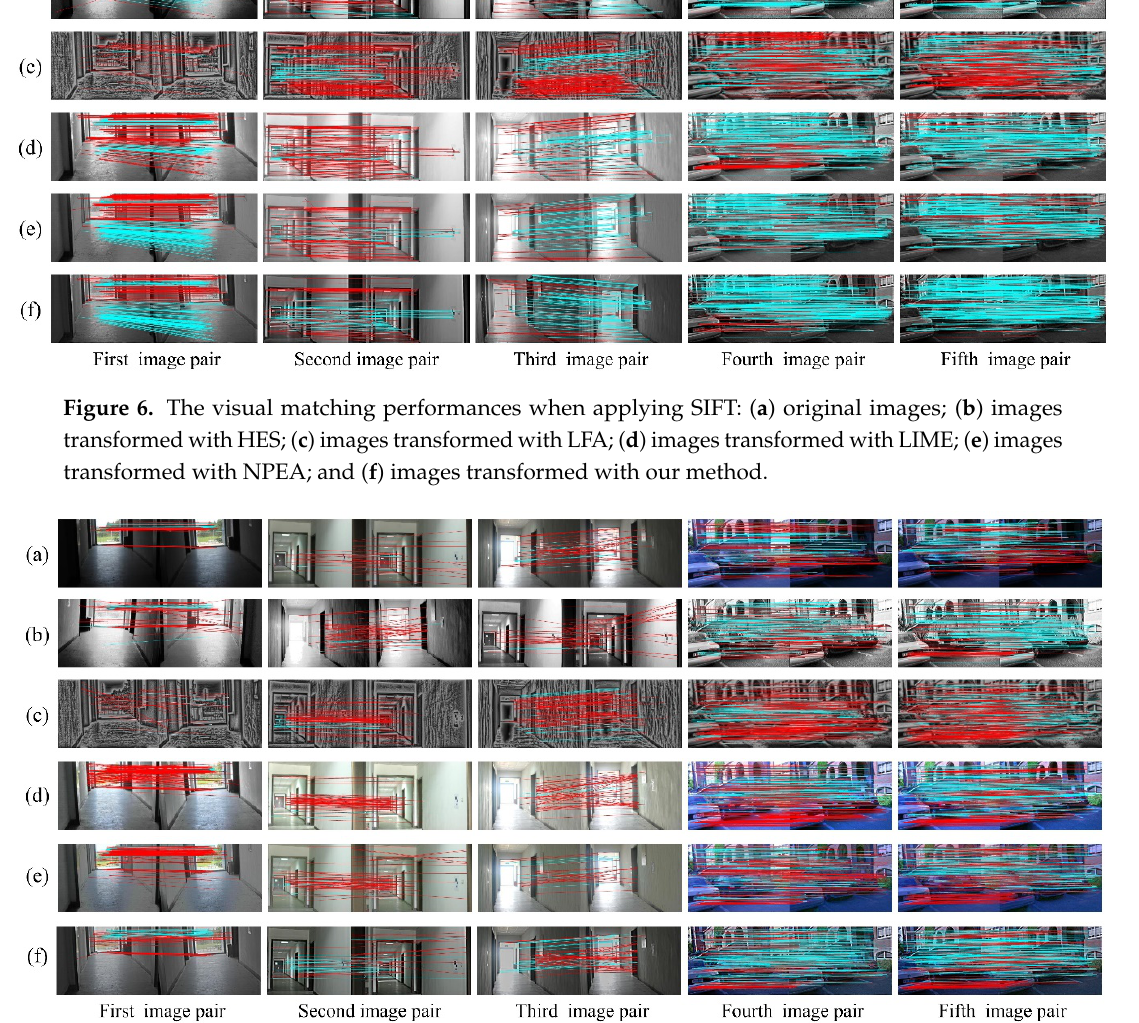
Figure 7. The visual matching performances when applying SURF: ( a ) original images; ( b ) images transformed with HES; ( c ) images transformed with LFA; ( d ) images transformed with LIME; ( e ) images transformed with NPEA; and ( f ) images transformed with our method.